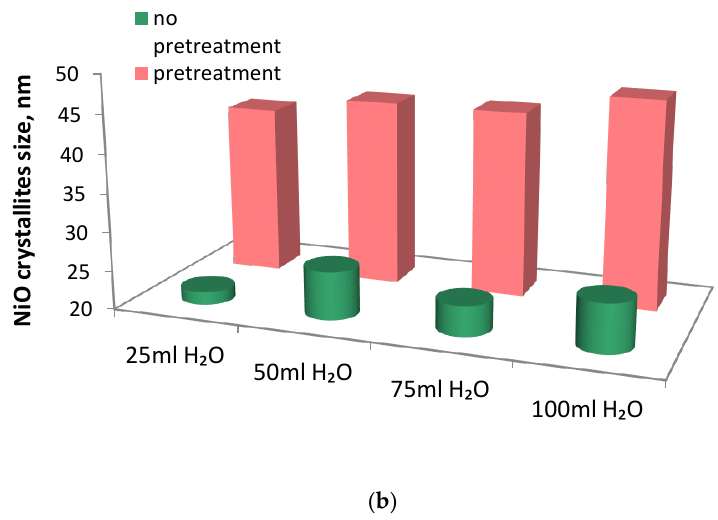
Figure 5. Influence of water quantity and heated stirring on the ( a ) Ni and ( b ) NiO crystallite size.